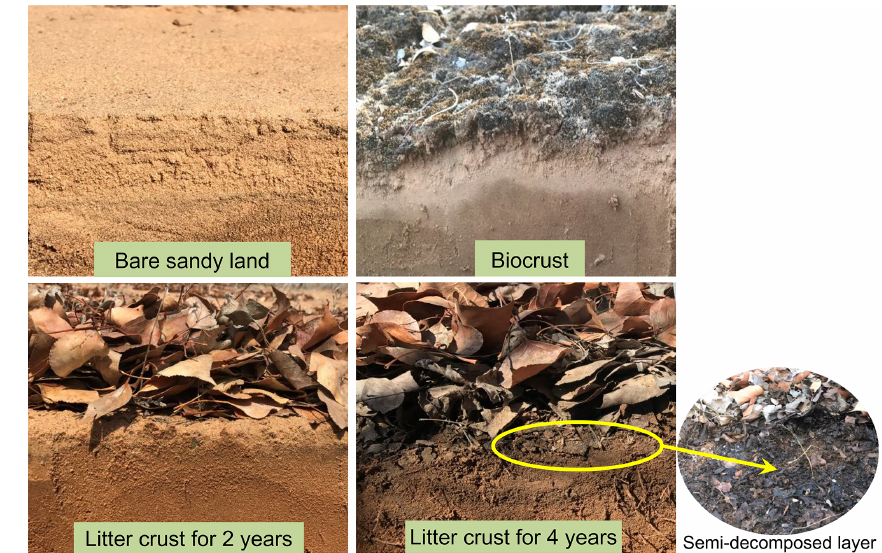
Figure 1. The vertical soil profiles in bare sandy land and different crusts in the southern Mu Us Desert.